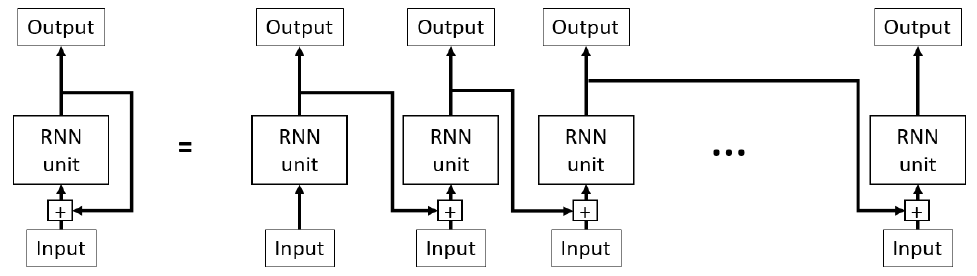
Figure 10. Schematic of an RNN.